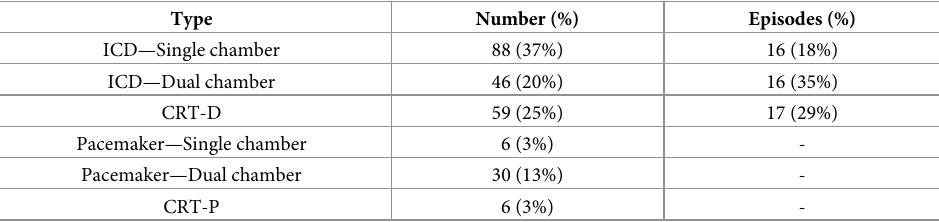
Table 1. Device types and